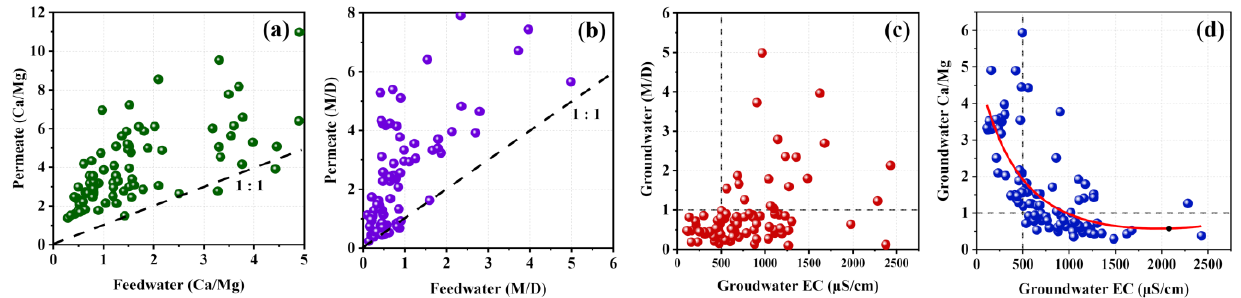
Figure 7. ( a ) Ca/Mg selectivity and permeability; ( b ) cation selectivity of monovalent/divalent (M/D) RO TFC membranes and ( c ) M/D ratio with groundwater EC; ( d ) Ca/Mg ratio with groundwater EC in NCP.